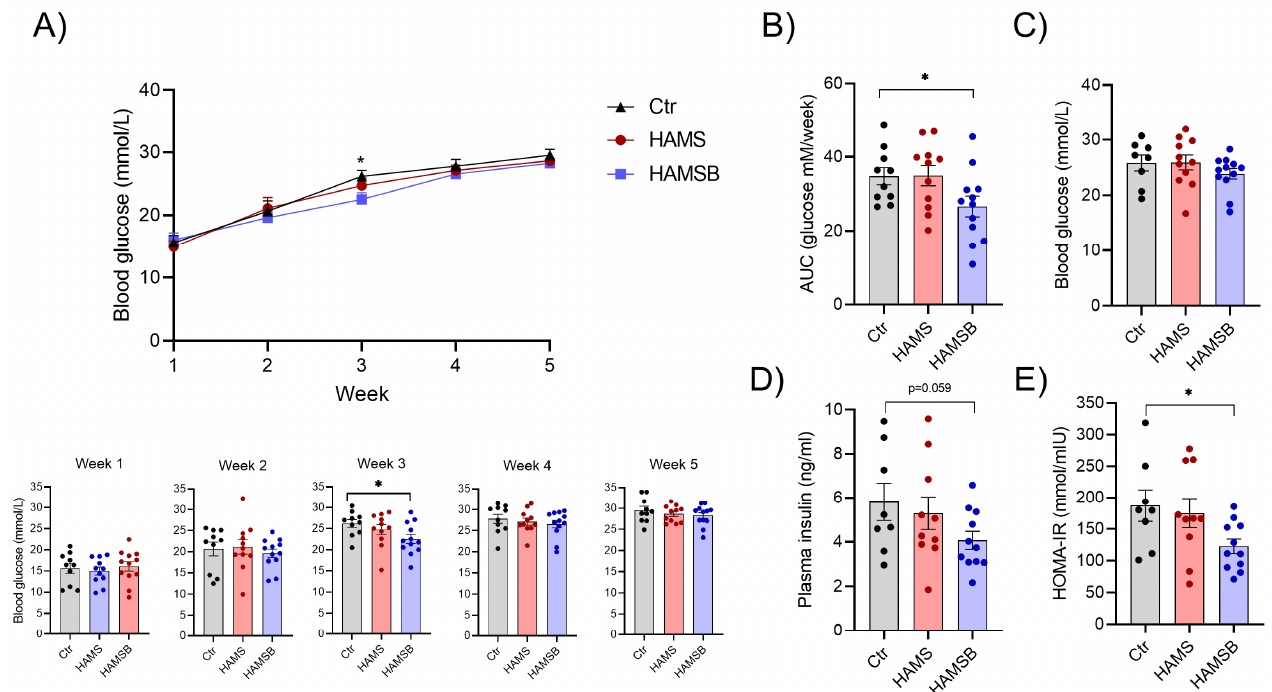
Figure 4. Glycemic control. ( A ) Weekly measurements of fasting blood glucose in db/db mice fed three different diets: Ctr, HAMS or HAMSB for 5 weeks. Blood glucose levels for each individual mouse in the different weeks are shown below the blood glucose curve. ( B ) Area under the blood glucose curve (AUC) was calculated for each mouse. On the day of termination after a 4 h fast, blood glucose ( C ) and plasma insulin ( D ) were measured and used to determine insulin sensitivity through HOMA-IR ( E ). Bars show the mean ± SEM. * p < 0.05. Each circle represents an individual mouse,